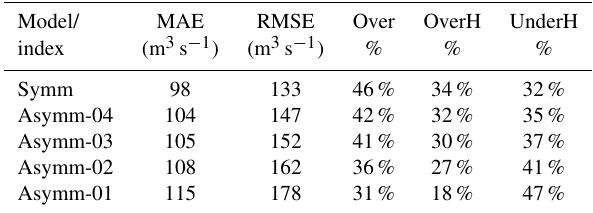
Table 2. Goodness-of-fit criteria of the 2-year floods estimates ob- tained by the symmetric and asymmetric networks on the indepen- dent test set of catchments. Model/ MAE RMSE Over OverH